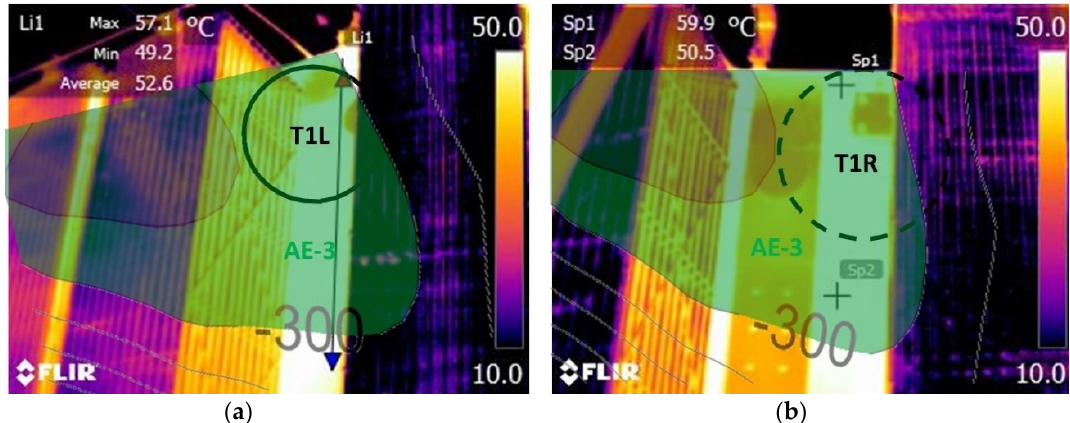
Figure 10. Thermograms of the IR radiation from the transformer’s surface recorded from both sides of the conservator taken in the springtime with quantitative information on the temperatures at the selected measurement points. T1L “hot spot”—the surface area with higher IR emissions delimited by a black circle ( a ). T1R “hot spot”—the surface area with higher IR emissions delimited by a black circle with a dashed line ( b ). The part of AE-3 area with increased activity ADC > − 300 is highlighted in green. T1L and T1R are the parts of AE-3.